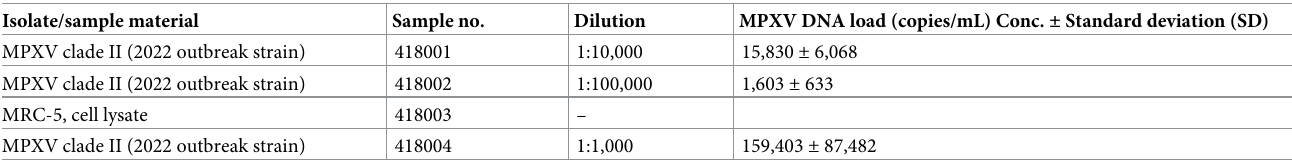
Table 1. Sample properties. Isolate/sample material Sample